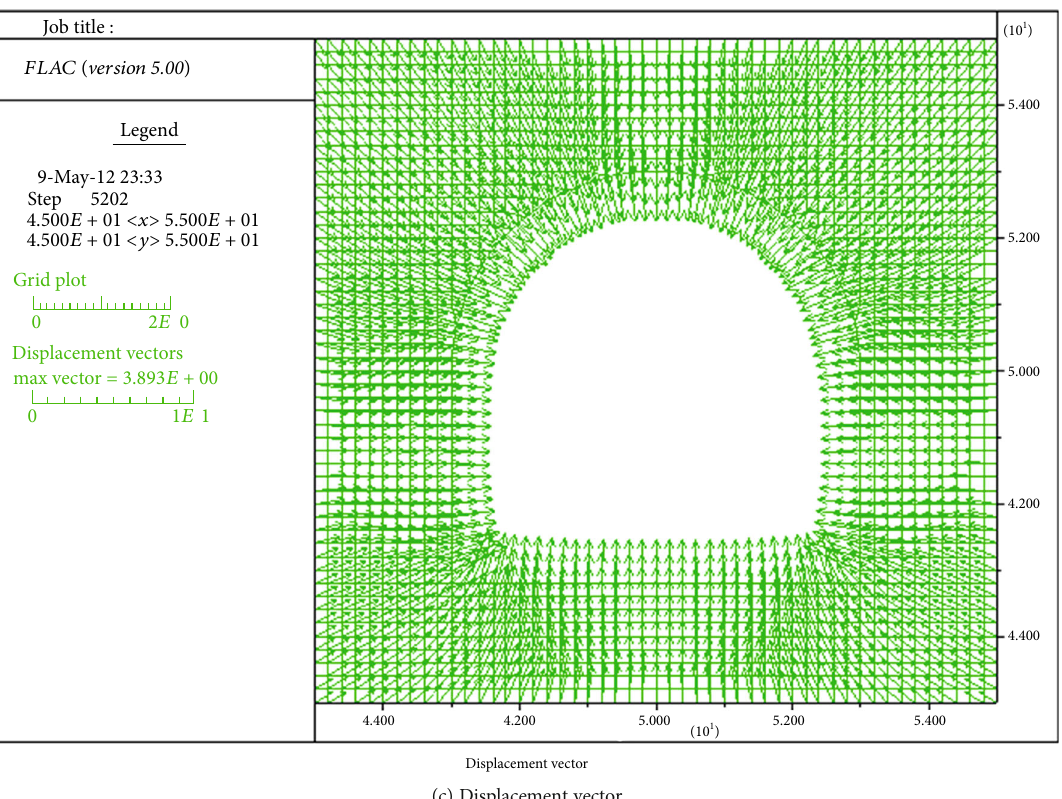
Figure 10: Movement rule of surrounding rock in the original support scheme.